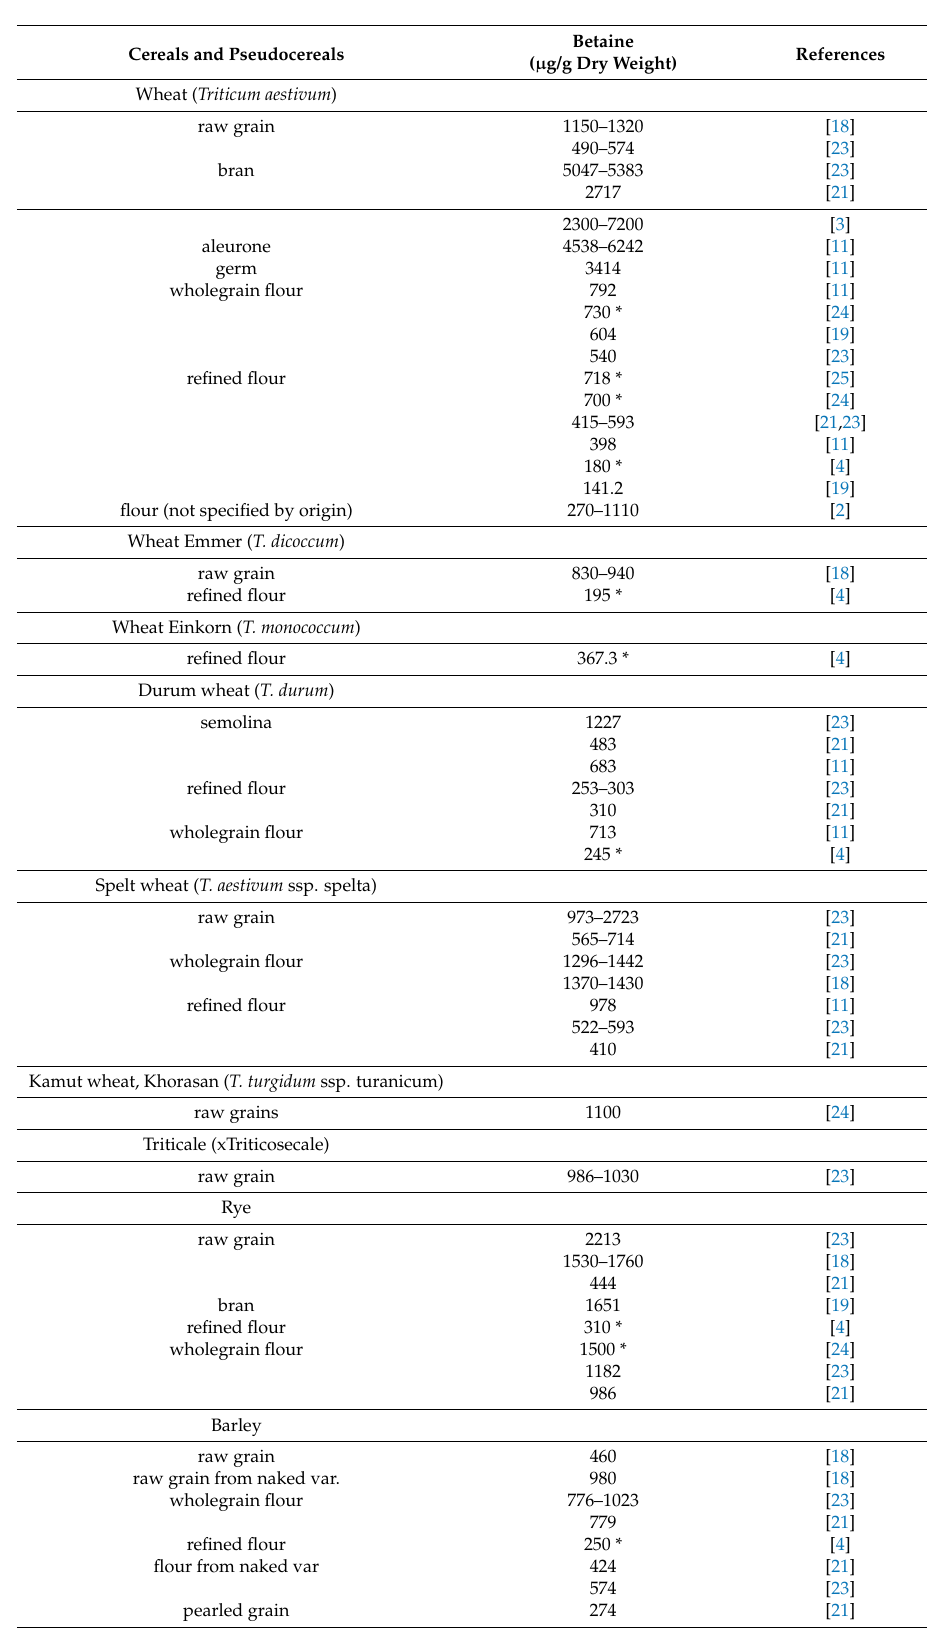
Table 1. Betaine content in different samples of cereals and